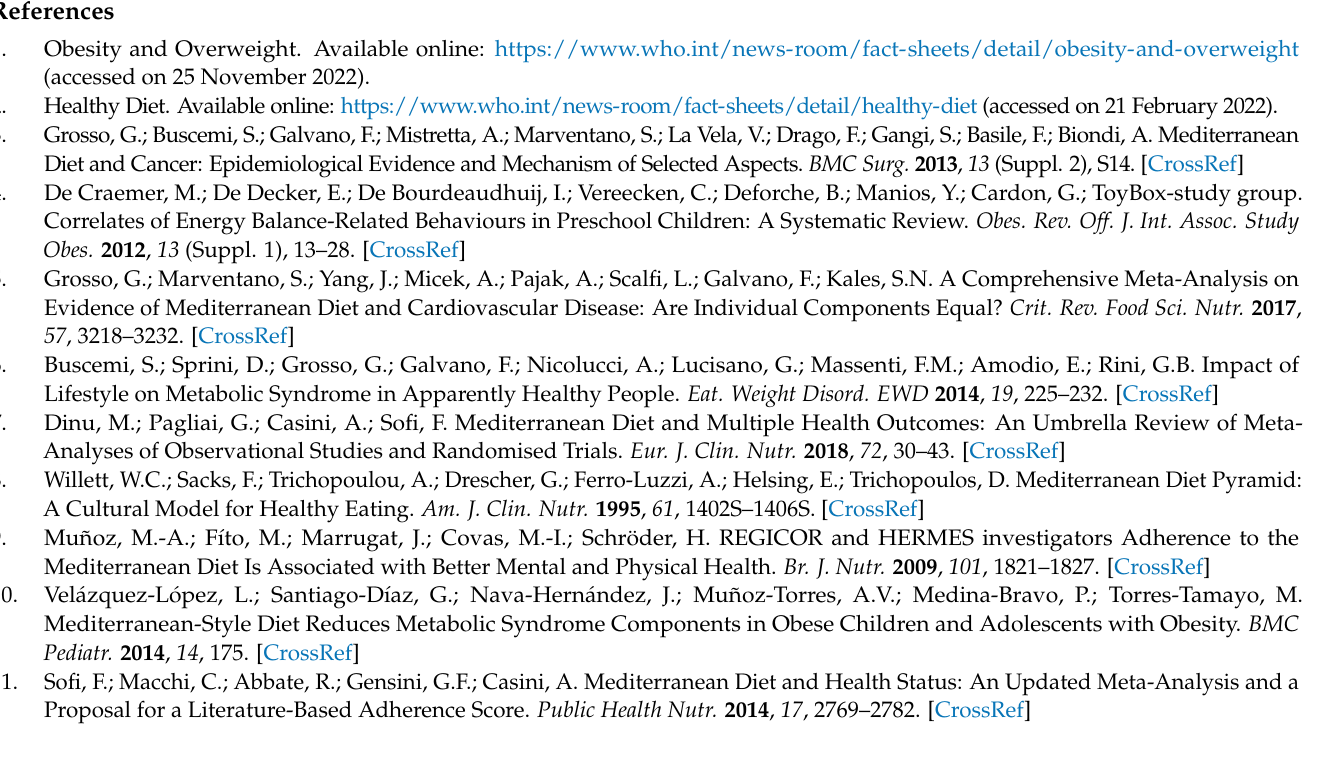
Table S3. Results of Univariate Analyses with Continuous Variables Predicting Leisure Screen Time (daily minutes). Table S4. Results of Univariate Analyses with Continuous Variables Predicting Minutes of Organized Physical Activity. Table S5. Results of Univariate Analyses with Continuous Variables Predicting Minutes of Vigorous Physical